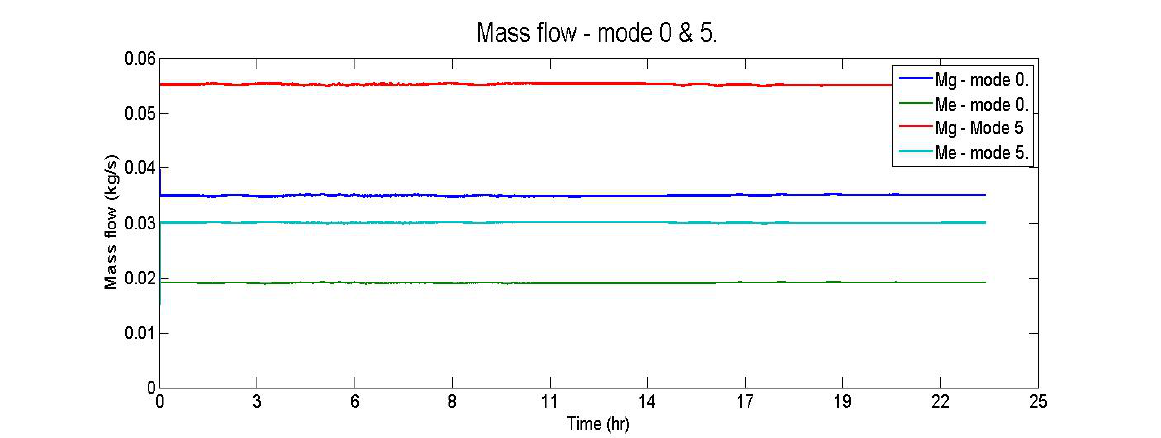
Figure 15. Cooling capacity for Modes 0 and 5.